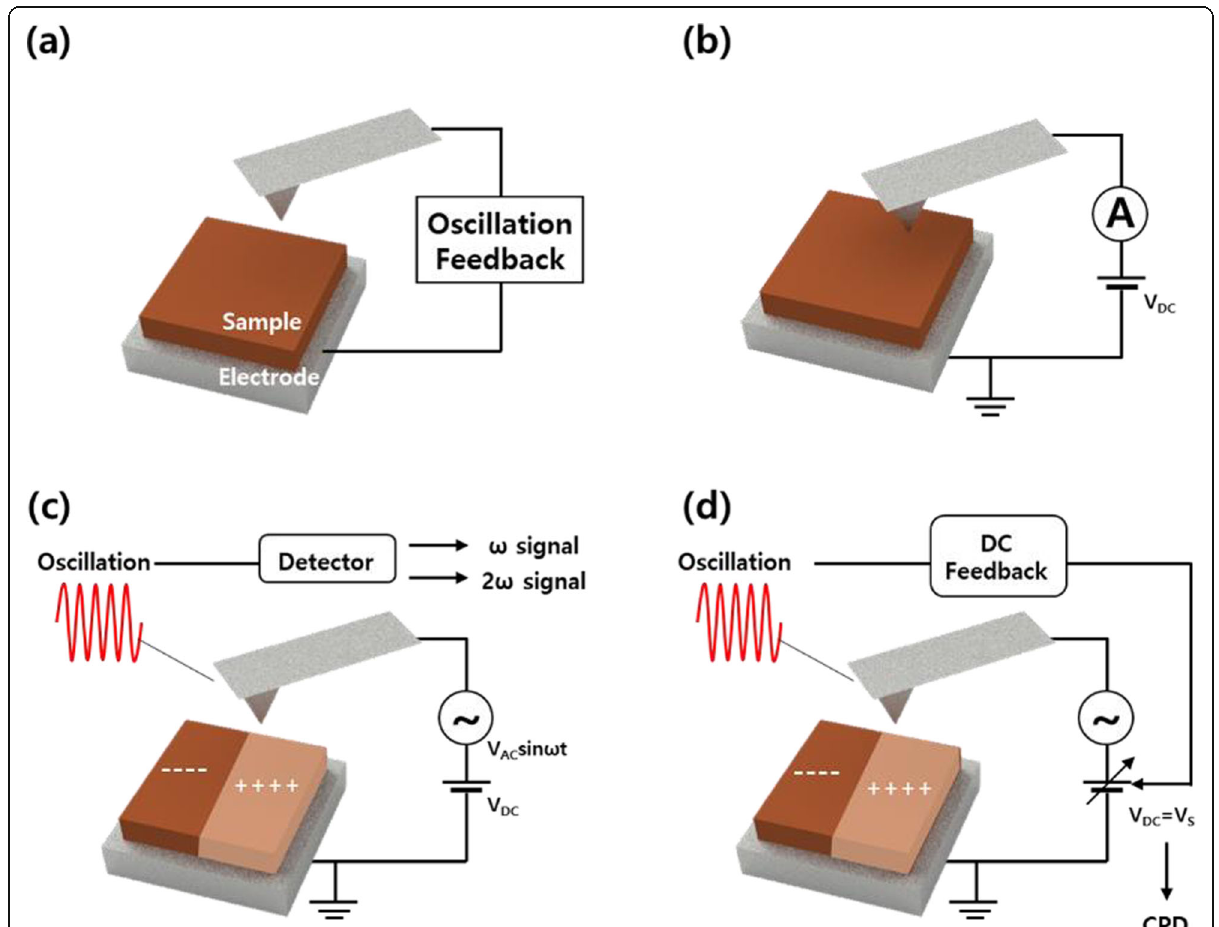
Fig. 1 Schematics of a conventional non-contact atomic force microscopy (NC-AFM), b conductive atomic force microscopy (C-AFM), c electrostatic force microscopy (EFM), and d Kelvin probe force microscopy